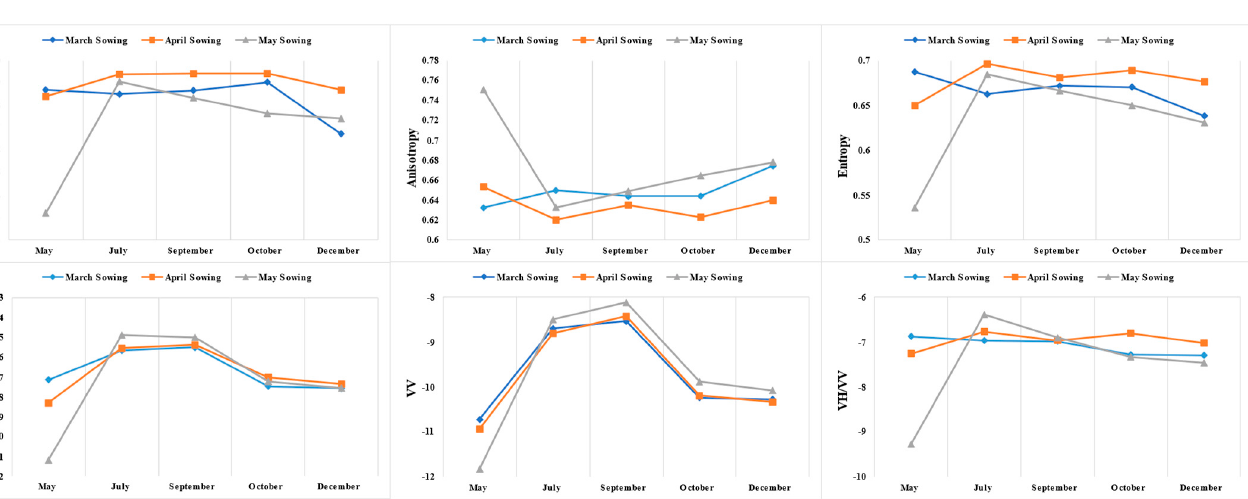
Figure 5. Temporal profile of Sentinel-2 indices. The above Figures 4 and 5 show the behaviour of Sentinel-1 parameters and Sentinel- 2 indices in different months for different sowing periods. By comparing the behaviour of Sentinel-1 parameters and Sentinel-2 indices with different image acquisition dates and other months, it is clear that Sentinel-2 indices were more responsive than Sentinel-2 pa- rameters to the months and Sentinel-1 parameters were more responsive than Sentinel-2 indices to different sowing dates. In Figures 6 and 7, we present the mean responses of Sentinel-1 and Sentinel-2 fea- tures in different phenological stages to visualise their behavior in different phenological stages.